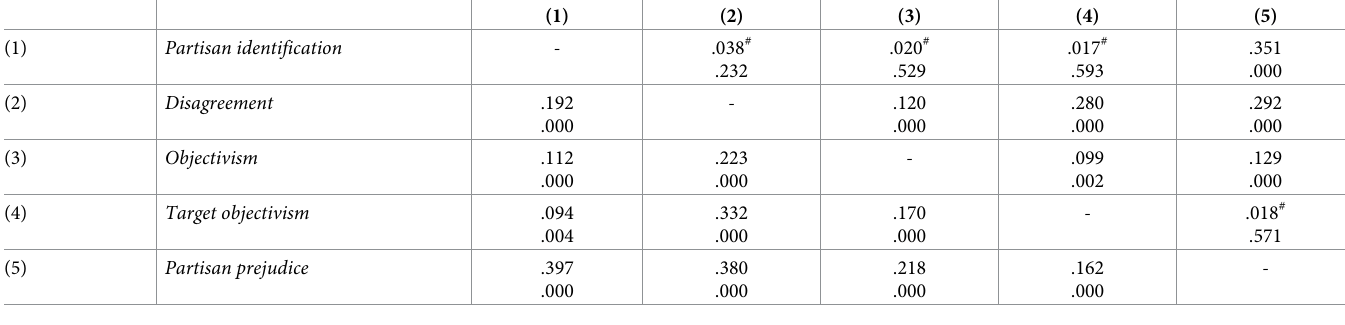
Table 4. Correlation table of partisan identification, morality measures, and partisan hostility (Spearman’s ρ coefficient, and p value). To eliminate common method variance and estimate the unique relationship between each pair of constructs, we report partial correlations above the